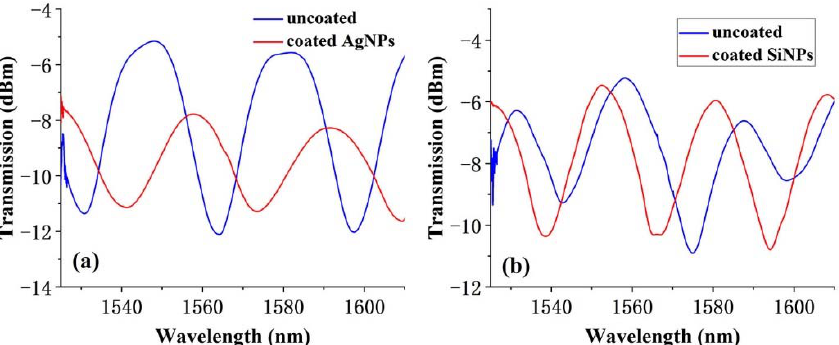
Figure 2. Spectra comparison of a clean microfiber taper with an elaborated microfiber taper by ( a ) silver and ( b ) silicon NPs.